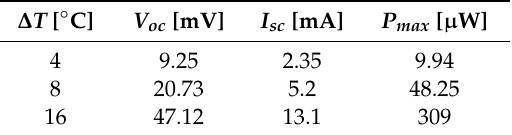
Table 1. Characterization of a single TEC1-3103 Peltier cell as TEG.